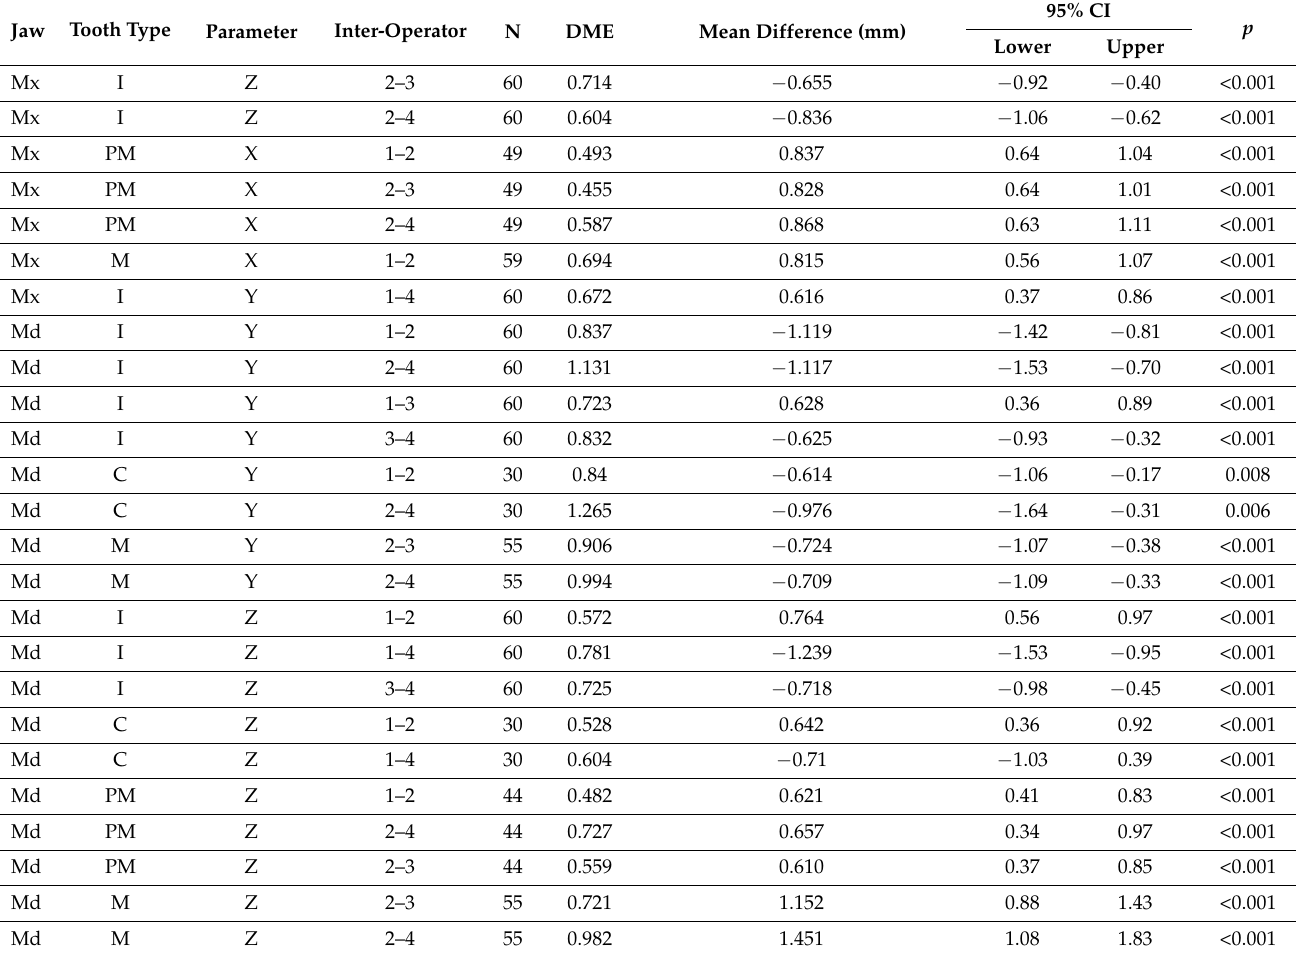
Table 1. Inter-operator mean differences, 95% confidence intervals (CIs), DME values, and result of the paired sample t test ( p -value) for differences in translations in maxilla and mandible larger than 0.6